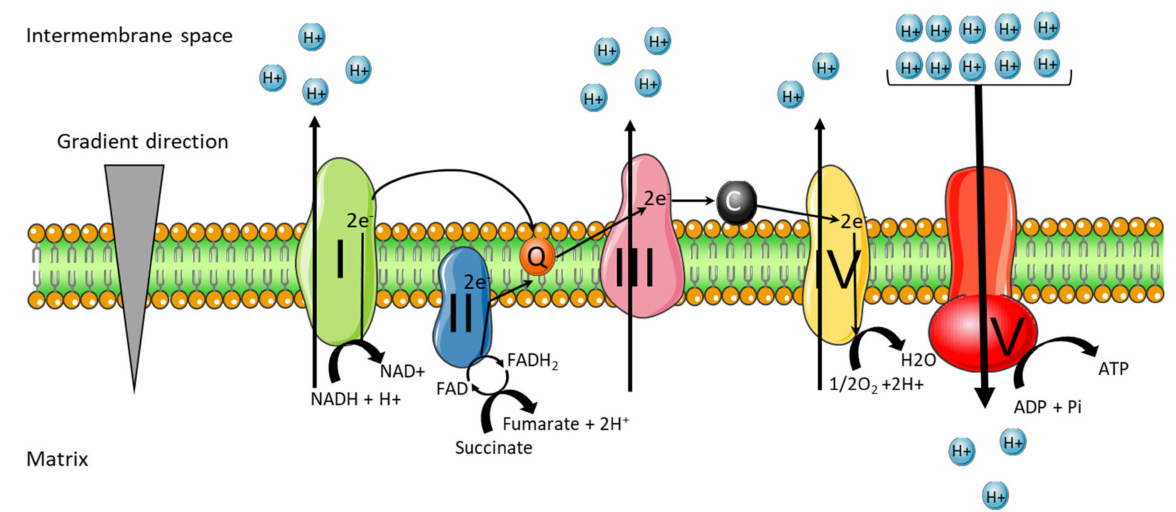
Figure 2. Mitochondrial respiratory chain complex. The mitochondrial respiratory chain is located at the inner membrane of the mitochondria. Composed of four complexes and two coenzymes, it allows the production of ATP through oxidative phosphorylation. Complex I (NADH: coenzyme Q oxidoreductase) and II (succinate dehydrogenase) will each transfer two electrons to the quinone coenzyme Q10 (CoQ10). The two electrons transferred from complex I come from the oxidation of NADH, and those from complex II come from oxidation of succinate to fumarate. CoQ10 will allow the transfer of electrons to complex III (CoQ10-cytochrome C oxidoreductase). The complex III will then pass these electrons to the cytochrome C, which makes the link with the complex IV (cytochrome C oxidase). The complex IV reduces O 2 in a H 2 O molecule. Complexes I, III and IV are proton pumps, which allow the passage of protons from the matrix to the intermembrane space, in the opposite direction of the gradient. Complexes I and III allow the passage of four protons and complex IV of two protons. Once the intermembrane space is enriched with protons, the last complex of the chain, ATP synthase will allow the passage of protons in the direction of the gradient. This proton flow will allow the synthesis of ATP from